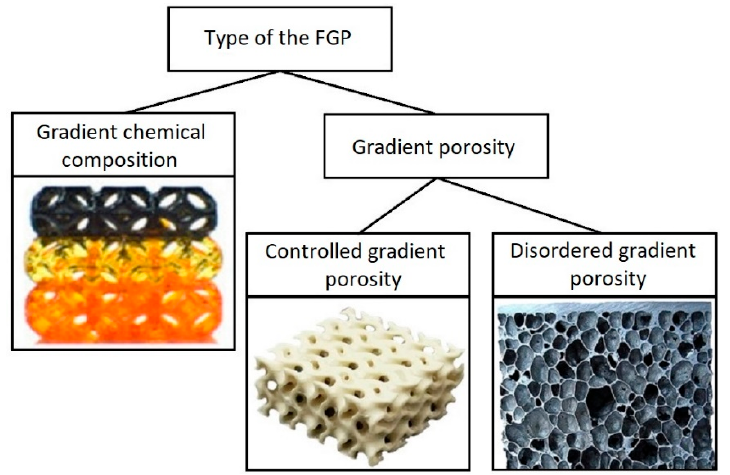
Figure 1. FGP classification by gradient type.